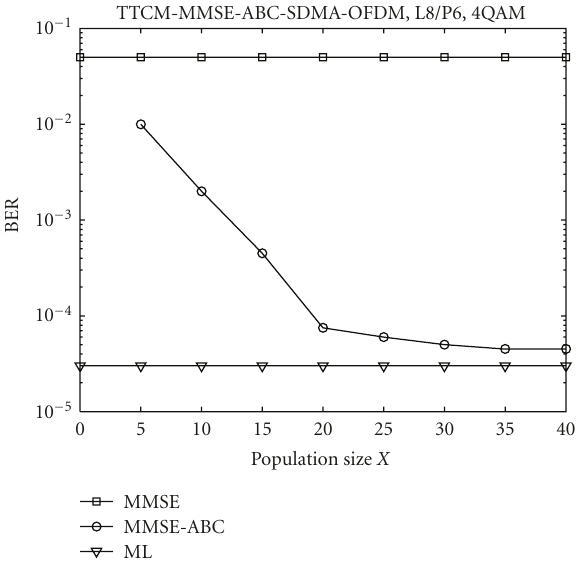
Figure 8: BER versus number of iterations performance with the population size fixed at X = 20 for 8 × 6